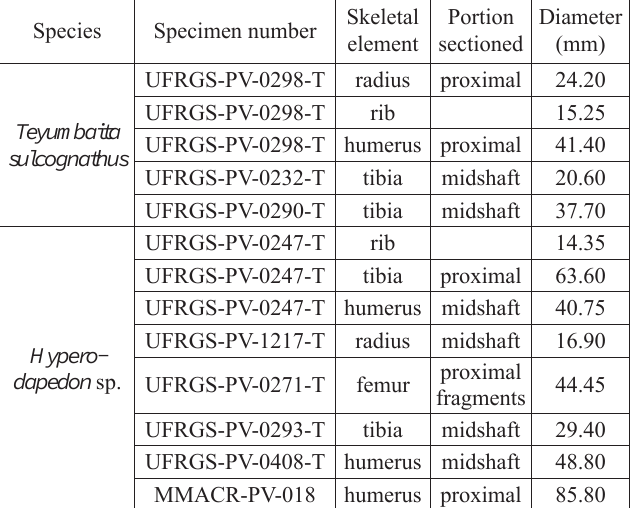
Holotype : UFRGS-PV-0232-T, complete skull, complete mandibles, atlas, axis, and following four cervical vertebrae, four disarticulated trunk vertebrae, sixteen disarticulated caudal vertebrae, partial gastra- lia, complete left scapulocoracoid, partial right scapulocoracoid, left humerus, right femur, right tibia, and two isolated phalanges.